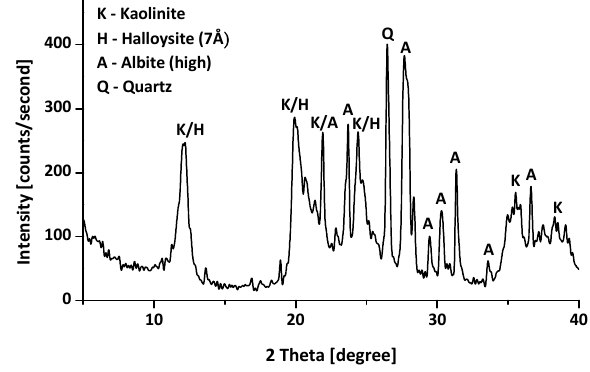
Figure 1. X-ray diffraction (XRD) pattern of the untreated kaolin clay.